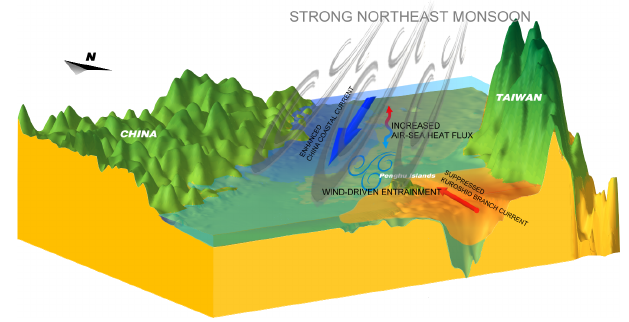
Figure 4. A cold-event sketch during La Niña